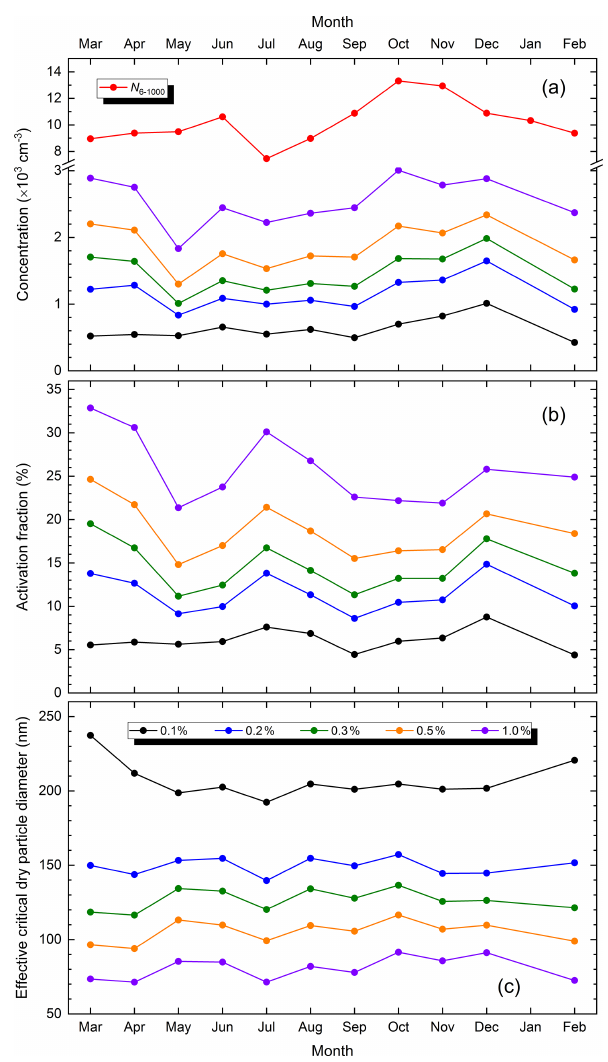
Figure 5. Time series of the monthly median CCN concentration and the total particle number concentration ( N 6–1000 ) (a) , the acti- vation fraction (b) and the effective critical dry particle diameter (c) at supersaturations of 0.1%, 0.2%, 0.3%, 0.5% and 1.0%.